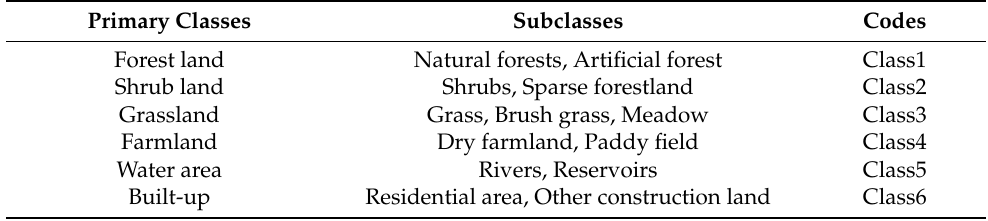
Table 1. Study area classification